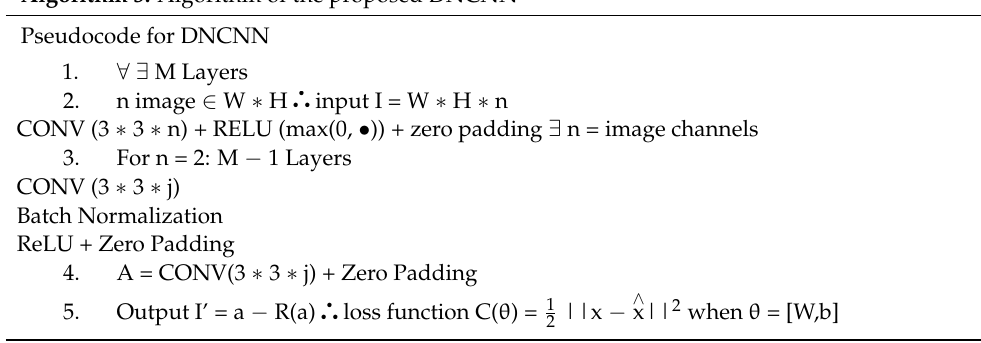
Algorithm 5 : Algorithm of OTSU